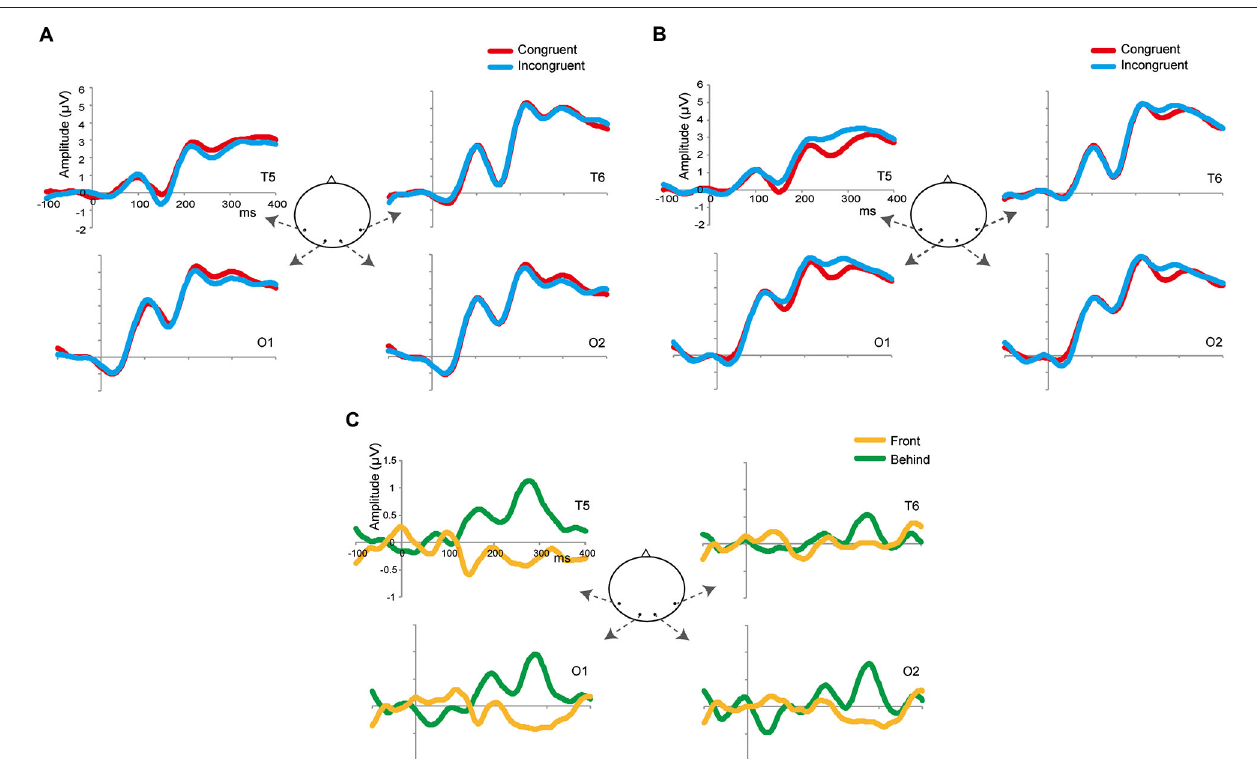
congruent condition; the blue waveforms denote the incongruent condition. (C) Grand-average subtracting ERPs (incongruent–congruent). The yellow waveforms denote the front condition; the green waveforms denote the behind condition.